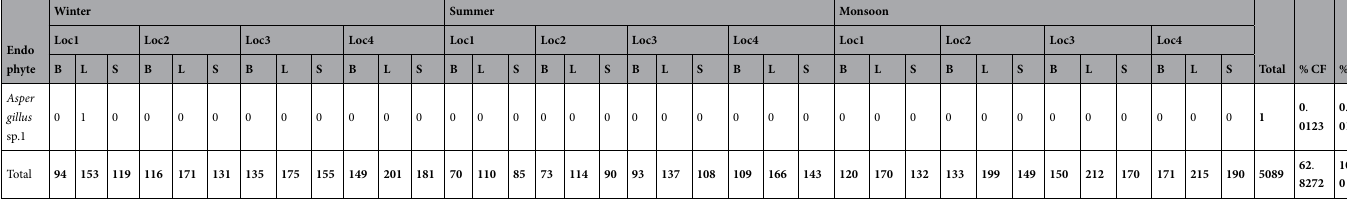
Table 2. Number, percent colonization frequency (%CF) and percent dominance (%D) of different fungal endophytes of T . grandis . Loc 1, 2, 3, 4 denotes location 1 to 4; B, L and S denotes bark, leaf and stem